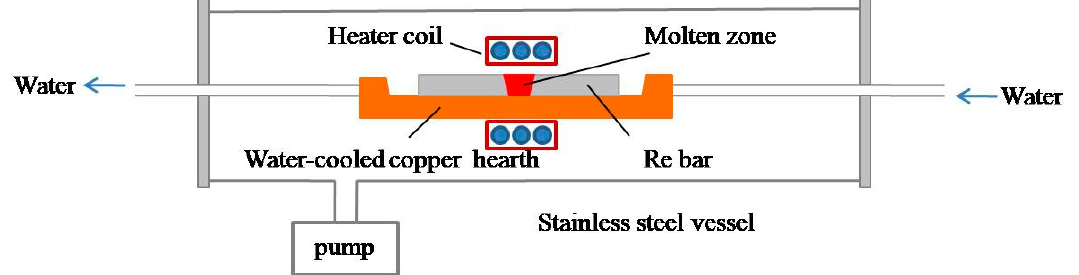
Figure 8. Schematic diagram of plasma arc zone melting.